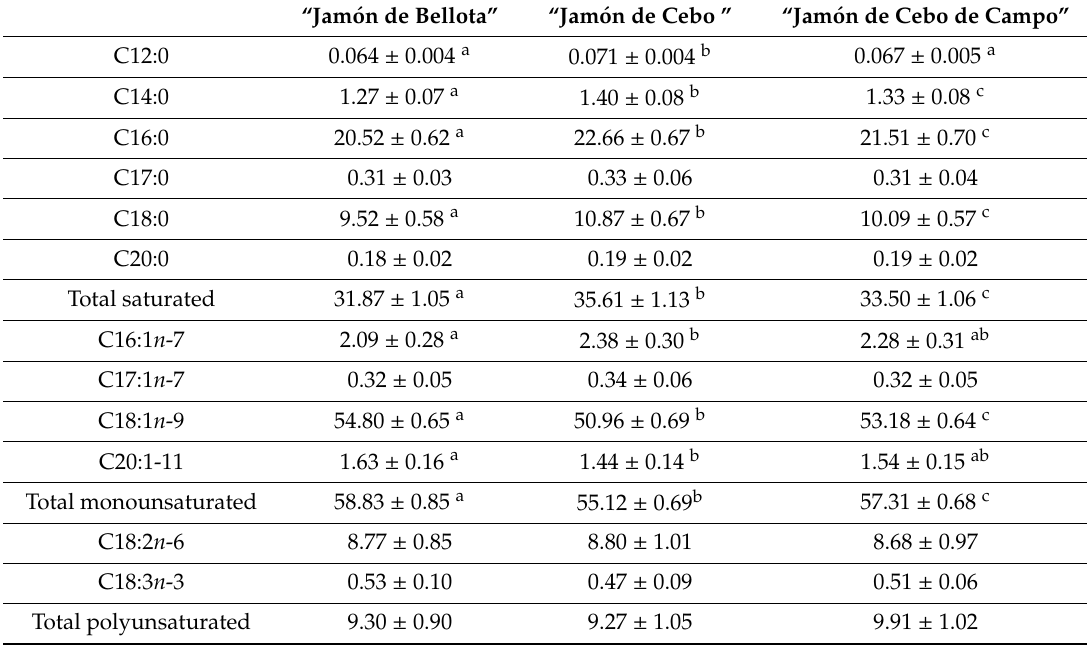
Table 2. Fatty acid composition of subcutaneous fat from Iberian hams (expressed as mean ± standard deviation of the percentage of total FAME content).